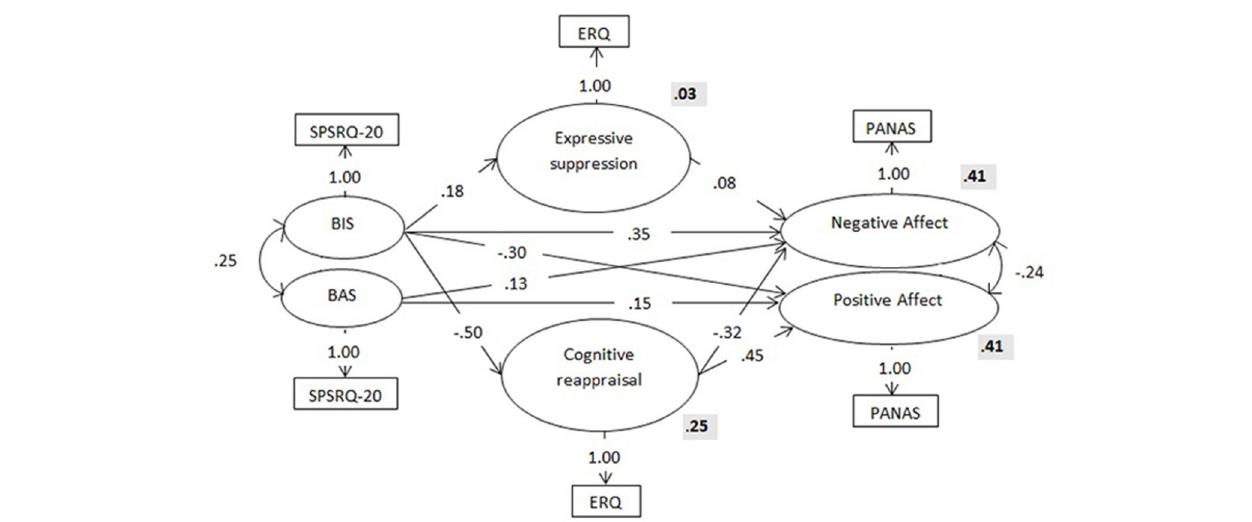
FIGURE 2 | Structure, standardized coefficients (in the arrows) and R 2 values (bold) for the final model. Observed variables are represented by circles and latent variables by square. SPSRQ-20, Sensitivity to Punishment and Sensitivity to Reward Questionnaire; ERQ, Emotional Regulation Questionnaire; PANAS, Positive Affect and Negative Affect